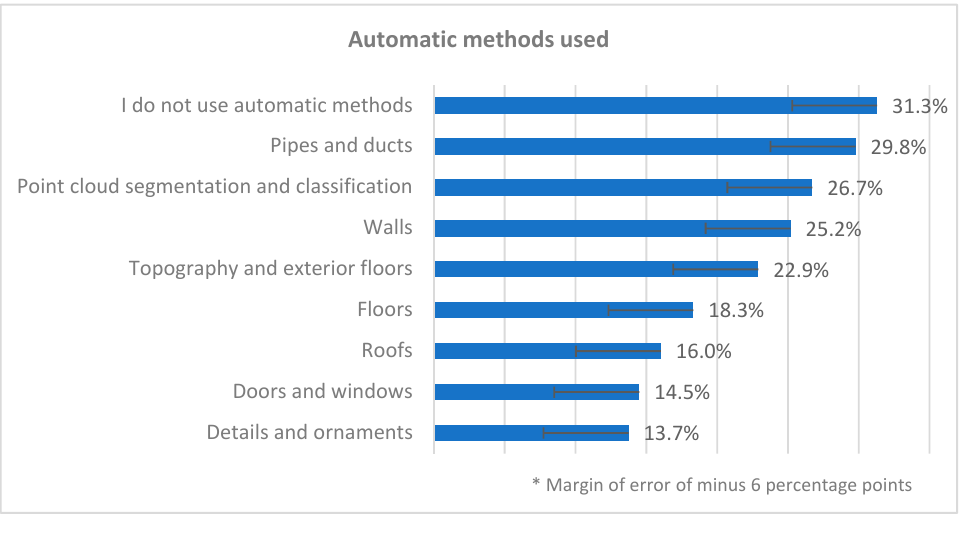
Figure 22. Building elements that the professional already use automatic methods for modeling.